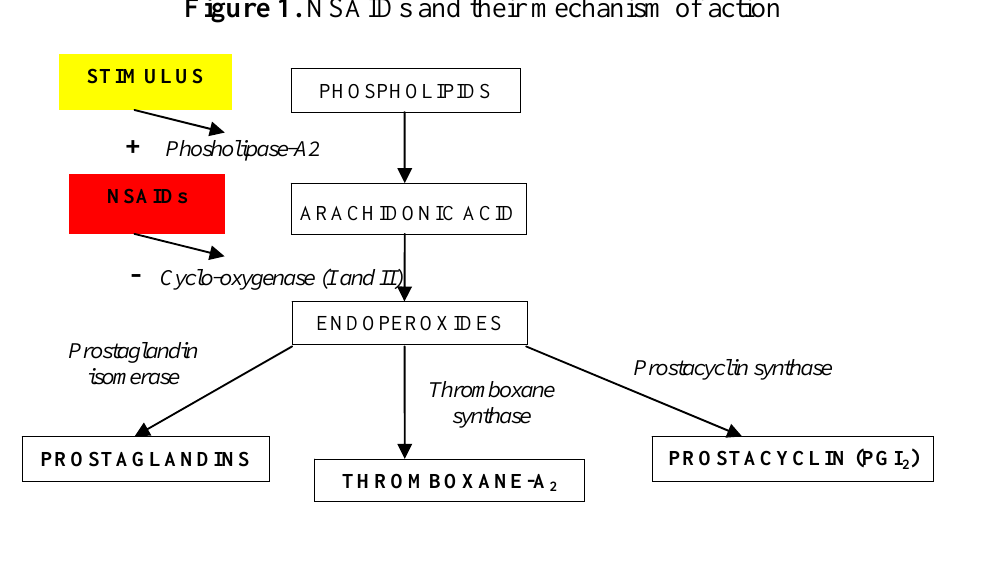
Figure 1. NSAIDs and their mechanism of